Question: What type of chart is this?
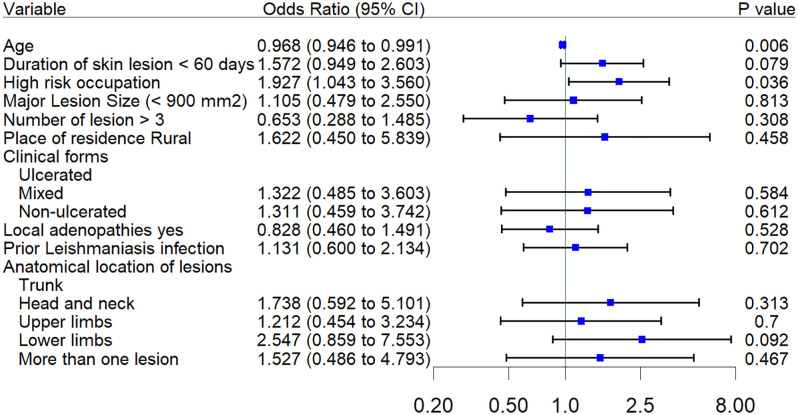
Answer: forest